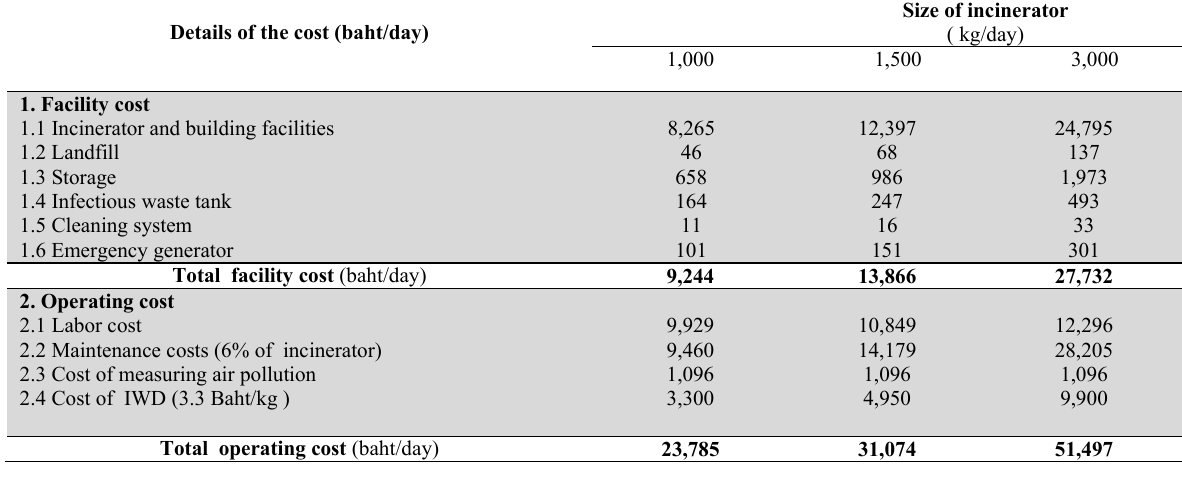
Details of the cost